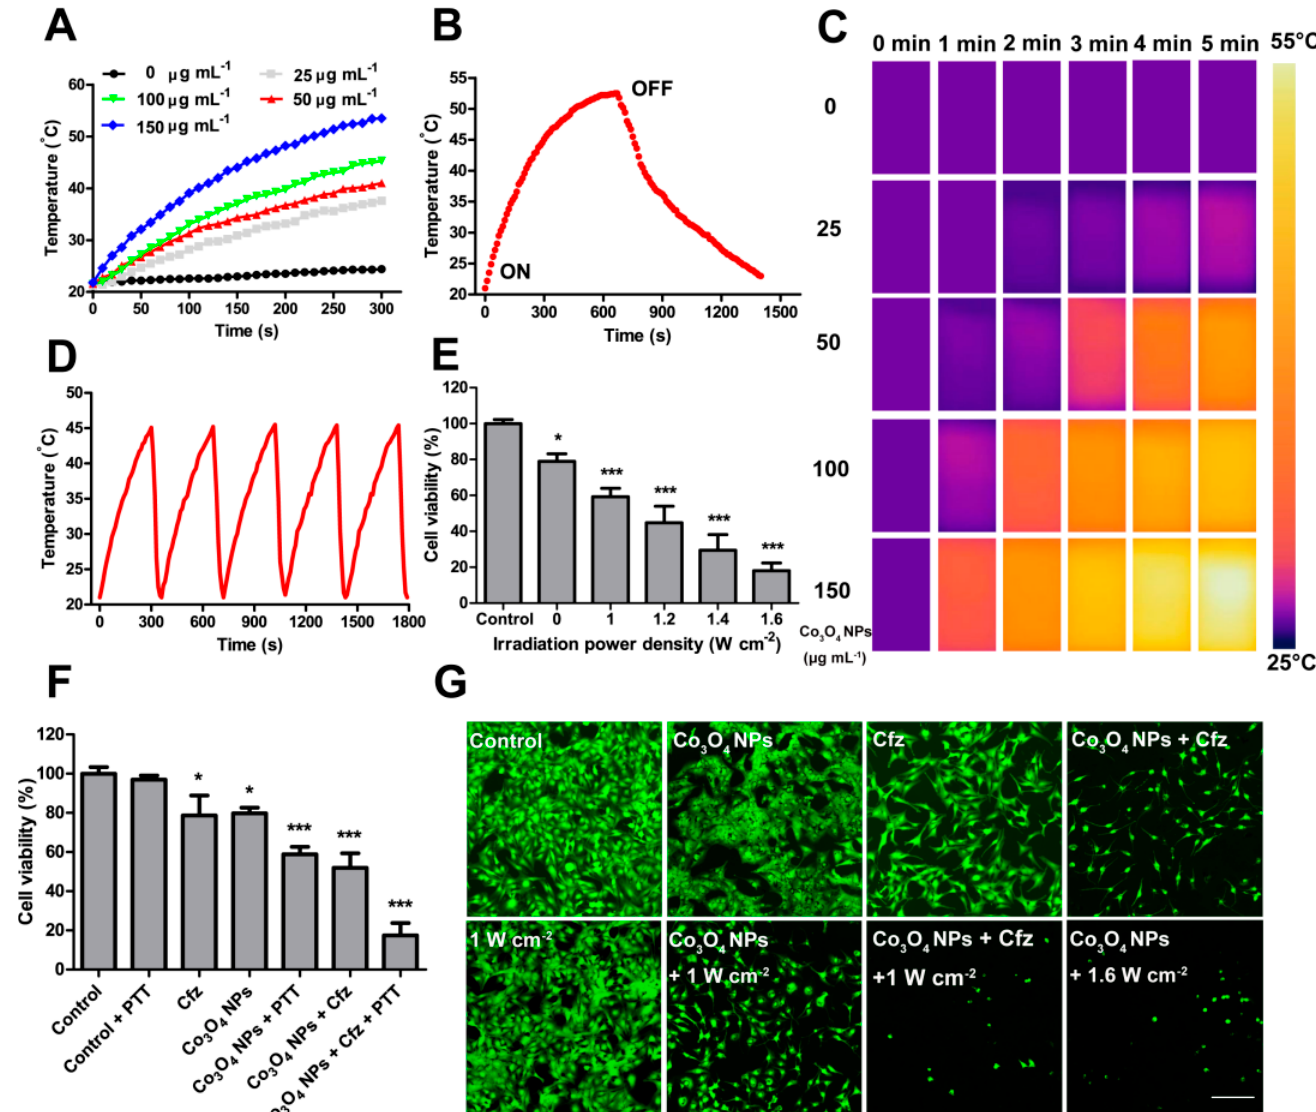
Figure 4. Co 3 O 4 NPs and photothermal therapy synergize to enhance the anticancer efficacy of Cfz in U-87 MG cells. ( A ) Temperature of the Co 3 O 4 NPs in aqueous solution over a period of 5 min exposure to laser irradiation (808 nm, 1 W·cm − 2 ) and ( B ) after cessation of laser irradiation. ( C ) Infrared thermal images of the Co 3 O 4 NPs in aqueous solution over a period of 5 min exposure to laser irradiation (808 nm, 1 W cm − 2 ). ( D ) Temperature of the Co 3 O 4 NPs in aqueous solution over 5 cycles of laser irradiation (808 nm, 1 W cm − 2 ). ( E ) Viability of U-87 MG cells after 75 μ g mL − 1 Co 3 O 4 NPs photothermal therapy at various laser power intensities (0 − 1.6 W cm − 2 ) for 5 min, N = 4/group, * p < 0.05, *** p < 0.001. ( F ) Viability of U-87 MG cells after treatment with Co 3 O 4 NPs and/or photothermal therapy and/or Cfz. N = 9/group, * p < 0.05, *** p < 0.001. ( G ) Representative calcein-AM staining of U-87 MG cells after treatment with Co 3 O 4 NPs and/or photothermal therapy and/or Cfz. Scale bar = 200 μ m. Values represent means ± S.D. Reproduced with permission from [20]. Copyright Elsevier, 2021.